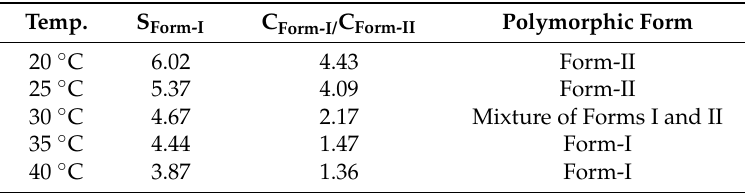
Table 3. The Supersaturation Level of Form-I (S Form-I ), and the Ratio of Solubility of Form-I/Form-II (C Form-I/Form-II ) in the Mixture of Solvent (ethanol)/Anti-solvent (IPA/Hex, 4:6, v/v) (5:5, v/v) at Temperatures Ranging from 20 to 40 ◦ C. The Initial Concentration of CLP in Ethanol was 100 mg/mL. Temp. S Form-I C Form-I/ C